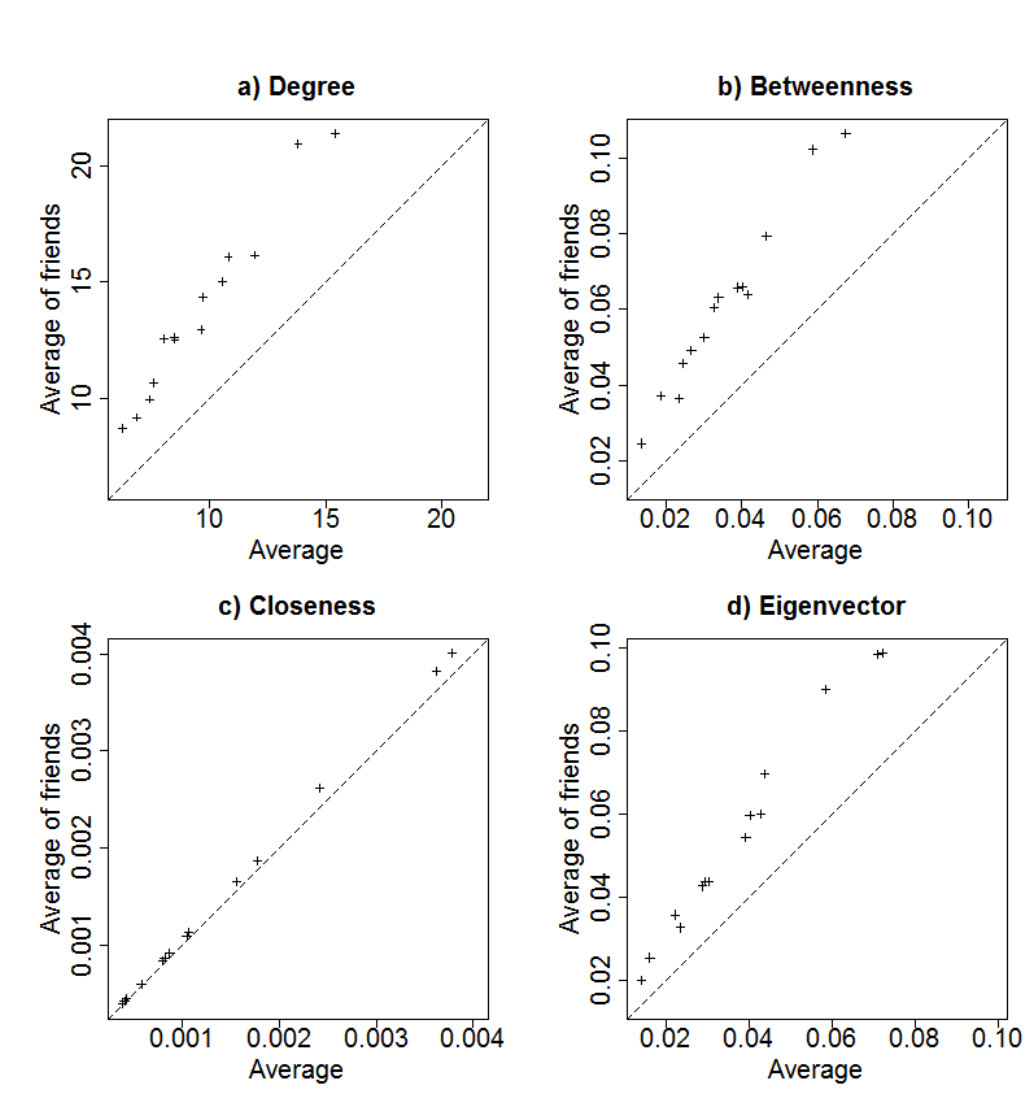
Figure 3: Average centrality and average centrality of friends in 14 schools in the United States